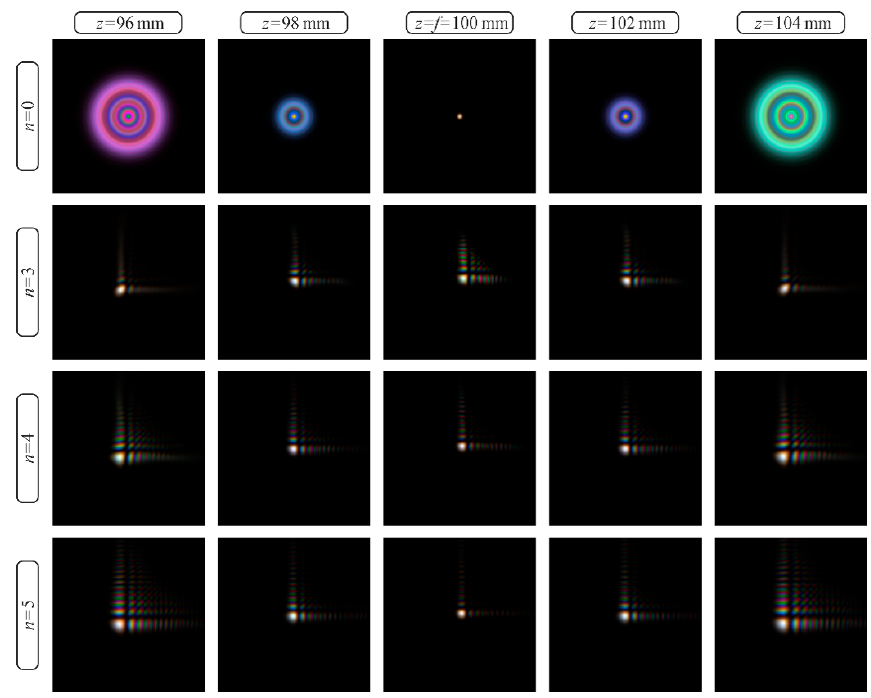
Figure 10. PSF at various distances with a CoC size limit of 0.02 mm (0.4 mm × 0.4 mm pattern size) for a lens without apodization (upper row) and with phase apodization n = 3, α = 0.00045 (second row); n = 4, α = 0.00054 (third row); and n = 5, α = 0.00081 (fourth row) at three wavelengths of the illuminating beam: λ = 460 nm (blue), 550 nm (green), and 640 nm (red). For a more visual comparison of the influence of the degree n of the apodization function, Figure 11 shows patterns of longitudinal distribution of PSF. This figure shows that the depth of focus decreases somewhat with increasing n , but the PSF distribution becomes more uniform and invariant to defocus, and there is less influence of chromatism.